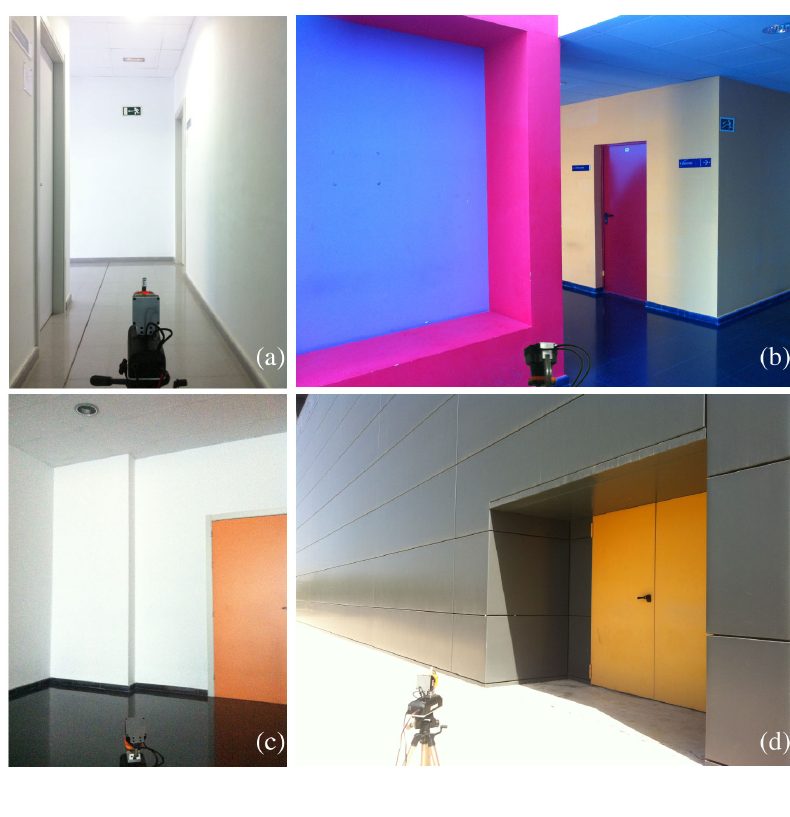
Figure 10. Verification experiment scenes: corridor ( a ); hall ( b ); room ( c ) and outdoor building front ( d